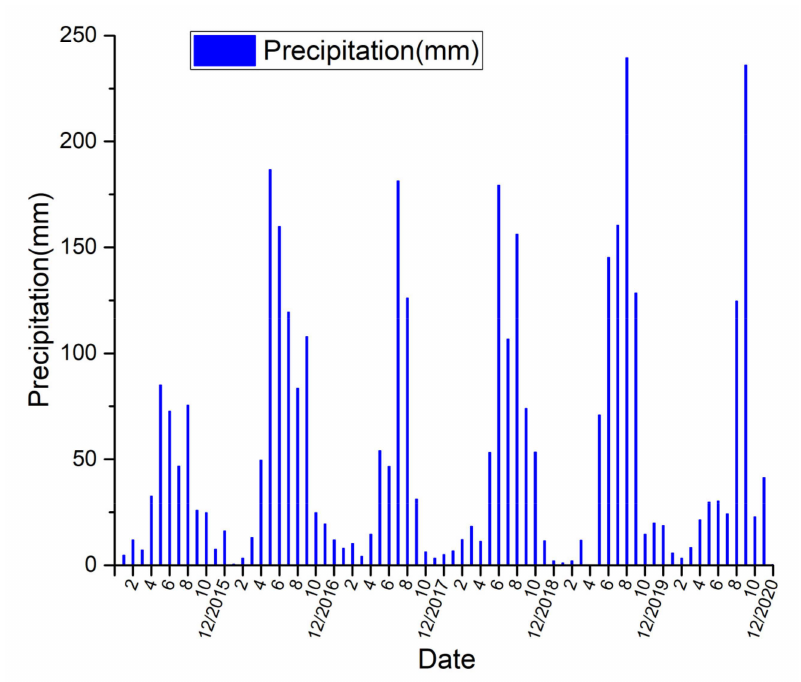
Figure 4. Monthly rainfall at Jiutai Station (~38 km from the study